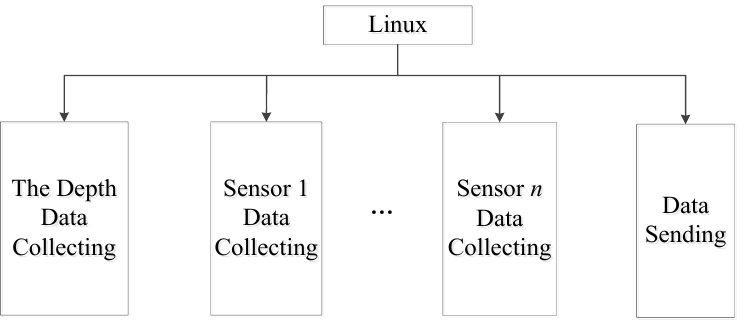
Figure 10. Multitasking controlled using Linux